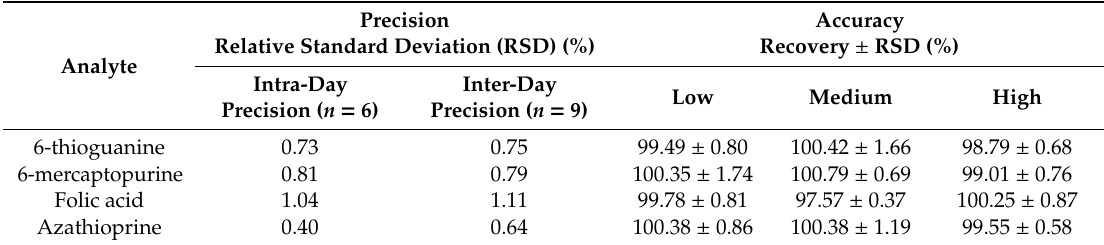
Table 5. Intra- and inter-day assay precision and accuracy